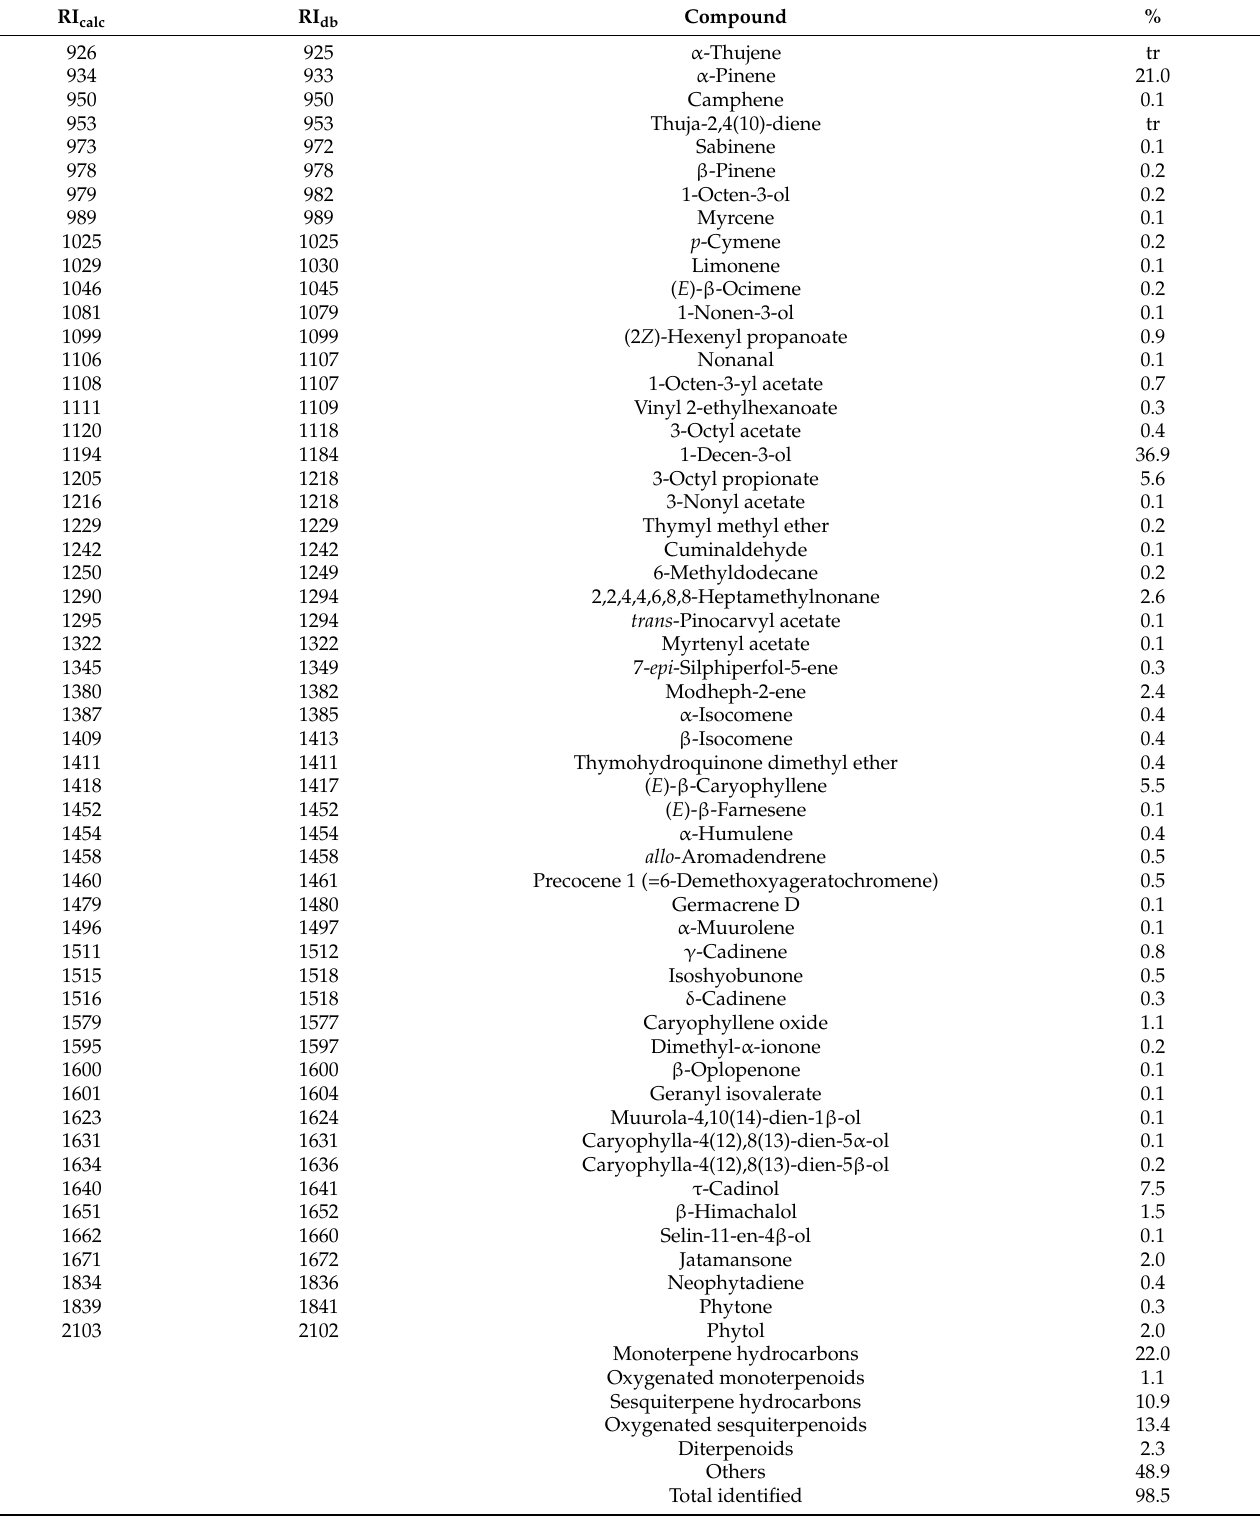
Table 5. Essential oil composition of Sphaeranthus africanus from